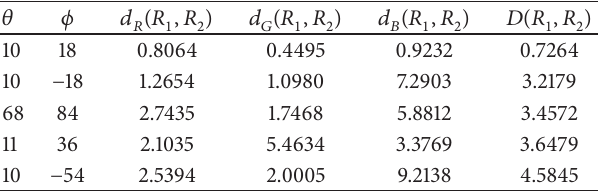
Table 3: Best distances from GEFS and SEFS based method with 𝜌 = 0.007813 for the pen image dataset obtained from the comparison with the sample image at 𝜃 = 10 ∘ and 𝜙 = 54 ∘